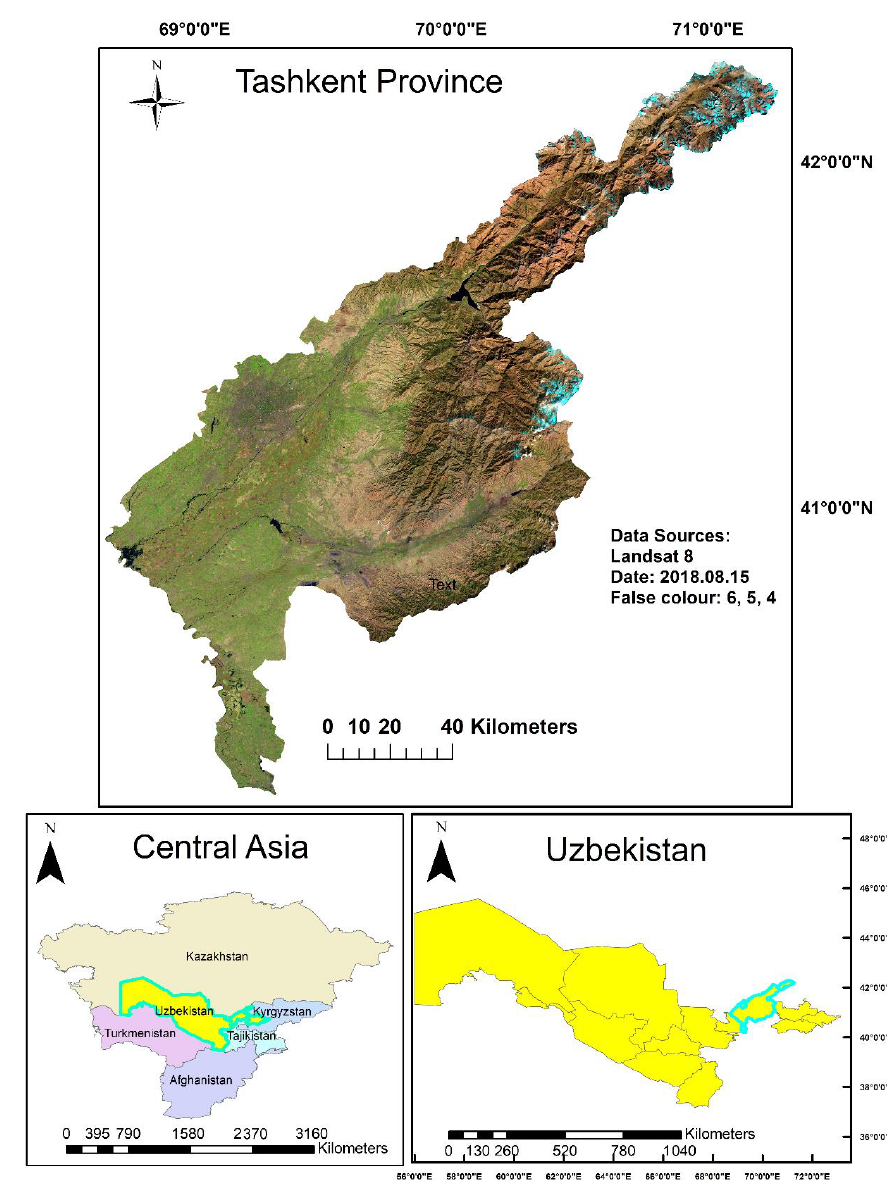
Figure 1. Location of the study region.